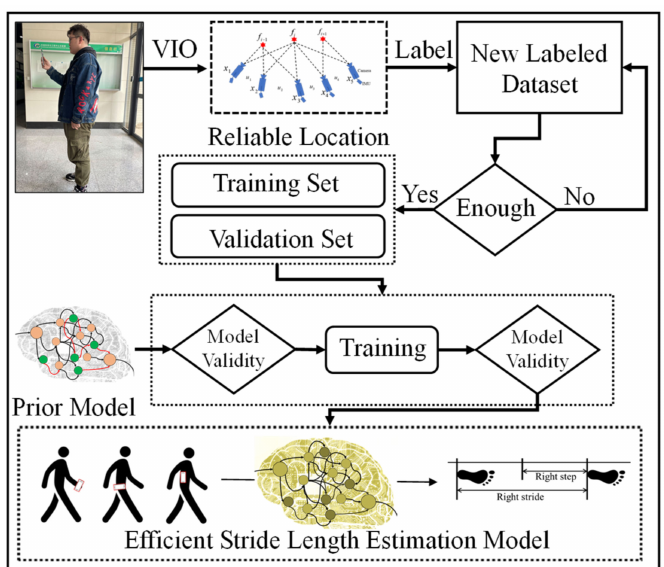
Figure 7. The framework of the updated SLE model based on online